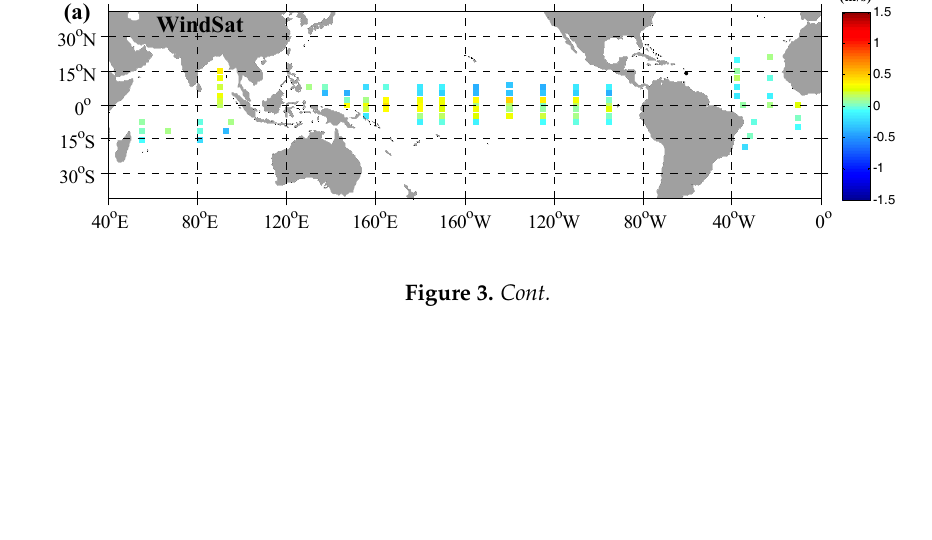
Figure 3. The mean difference (denoted by the color of each box) of wind speeds between satellite and buoy at each buoy site: ( a ) WindSat; ( b ) SSMIS F16; ( c ) SSMIS F17; ( d ) AMSR-E; and ( e ) AMSR-2. The results for SSMIS F16 (see Figure 3b) are similar to those of SSMIS F17 (see Figure 3c). For buoys in a band from − 8°S to 4°N, the overall wind speeds of SSMIS F16 and SSMIS F17 are both lower than buoy measurements, by approximately 0.3–0.4 m/s. Overall, the two satellite-derived winds are lower than the buoy observations in the tropical Indian Ocean and the tropical Atlantic Ocean. The results for AMSR-E (see Figure 3d) are similar to those of AMSR2 (see Figure 3e). In the tropical Atlantic Ocean, the two satellite-derived winds tend to be higher than buoy observations, which are different from the three other satellite wind speeds. The global maps of the wind speed RMSE are shown in Figure 4. Each square represents one buoy, and the color of the square indicates the RMSE between buoy observations and satellite- derived winds. Figure 4 shows that the results of WindSat are better than those of the four other 40 o E